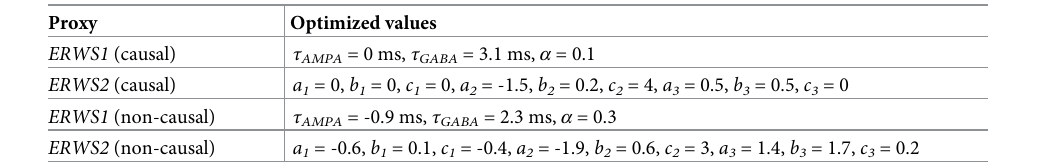
Table 1. Parameters of ERWS1 and ERWS2